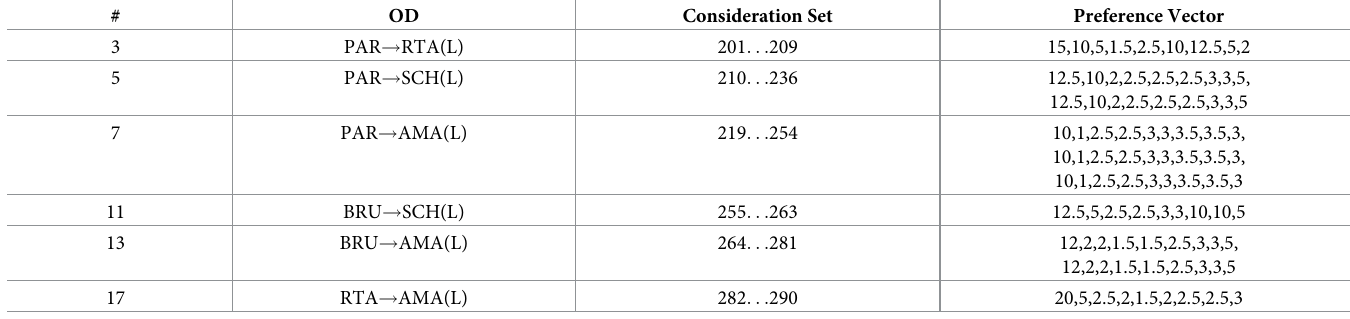
Table 9. Additional consideration set and preference vector with discount coefficient β = 0.5.